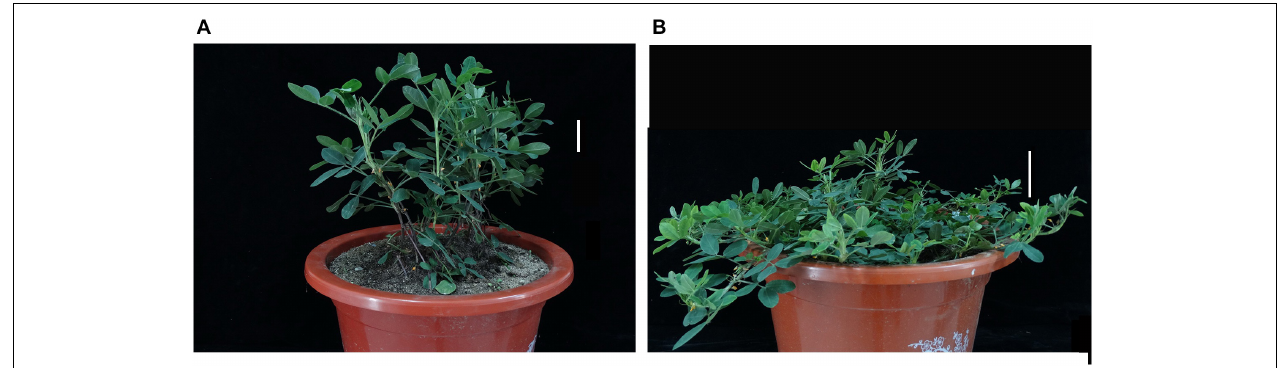
FIGURE 1 | The different phenotypes in the parents. (A) The female parent “Jihua 5” with scale bar of 10 cm. (B) The male parent “M130” with scale bar of 10 cm.